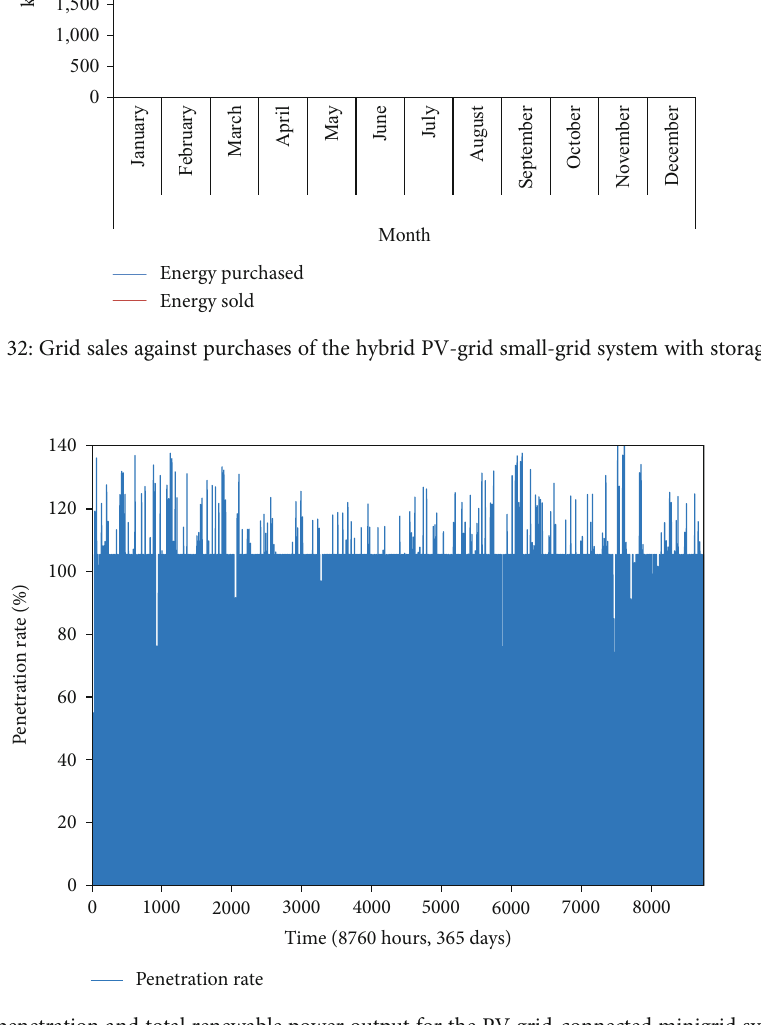
Figure 33: Renewable penetration and total renewable power output for the PV grid-connected minigrid system with